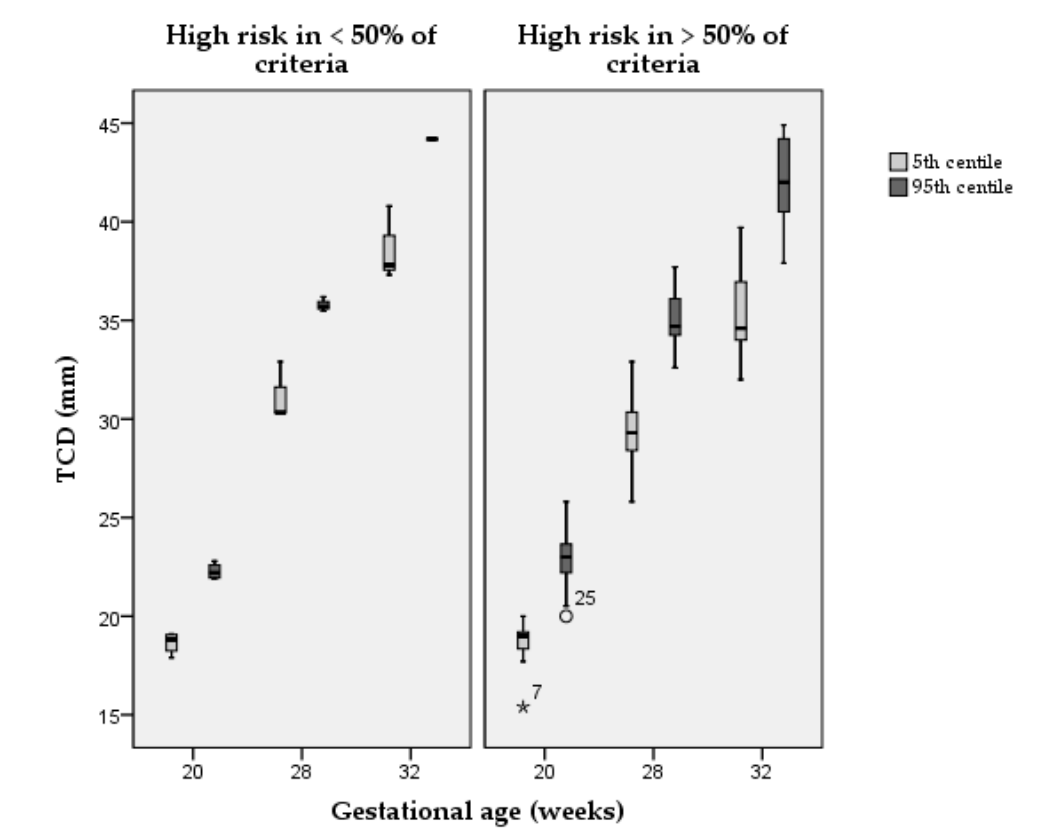
Centiles highlighted in white are reported in the relative study; centiles highlighted in grey are calculated. Studies are reported in descending quality score. SD= standard deviation; POF = parieto-occipital fissure; SF = Sylvian fissure; AV = anterior ventricle; PV = posterior ventricle; TCD = transcerebellar diameter; CM = cisterna magna; GA = gestational age.